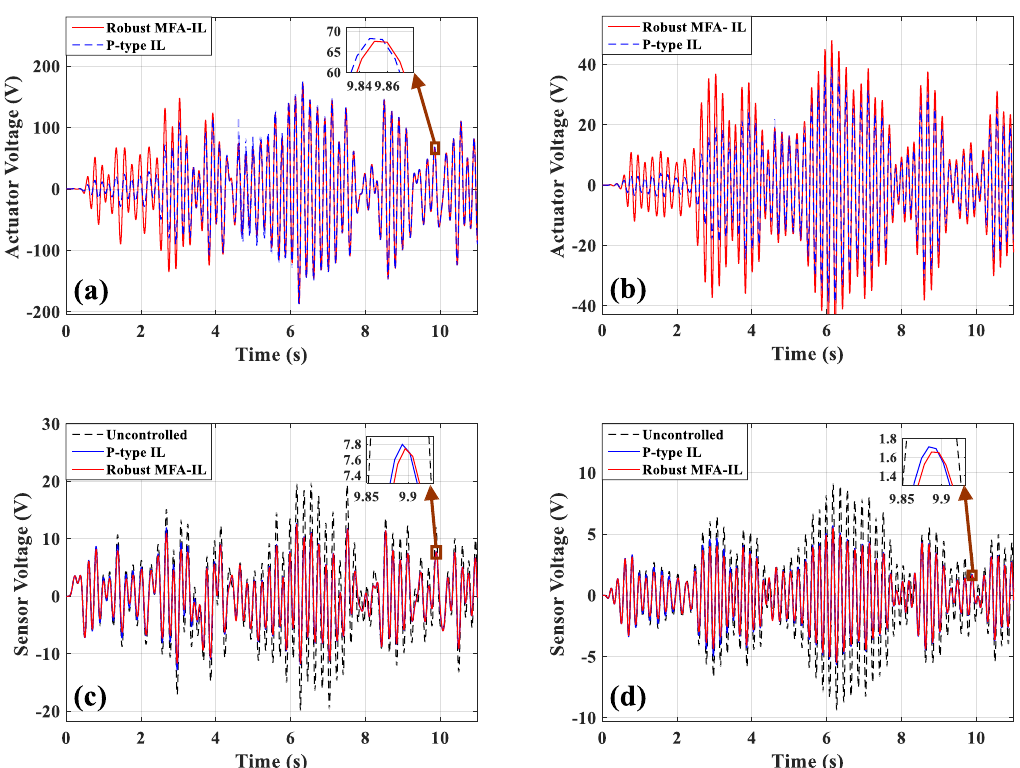
Figure 11. The time-domain responses of actuators/sensors: ( a ) Actuators a / b , ( b ) actuator c , ( c ) sensors a / b , ( d ) sensor c .